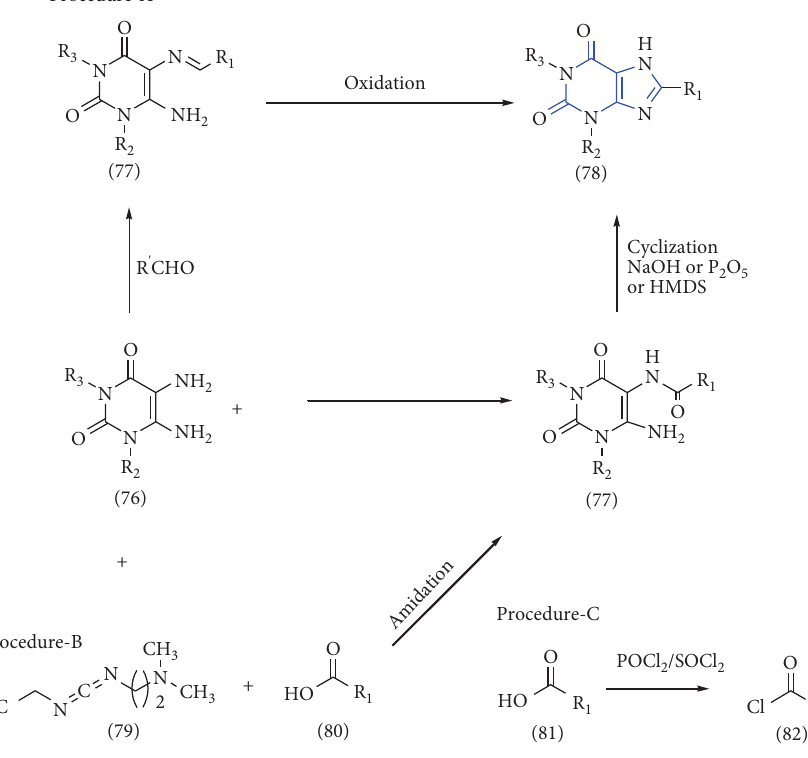
Scheme 12: Synthesis of 8-substituted xanthine derivatives.